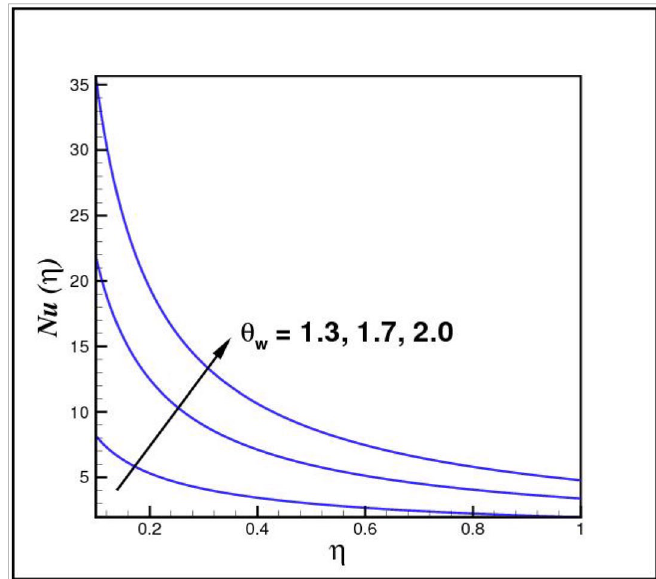
Figure 18. Impact of θ w on Nu ( η ).